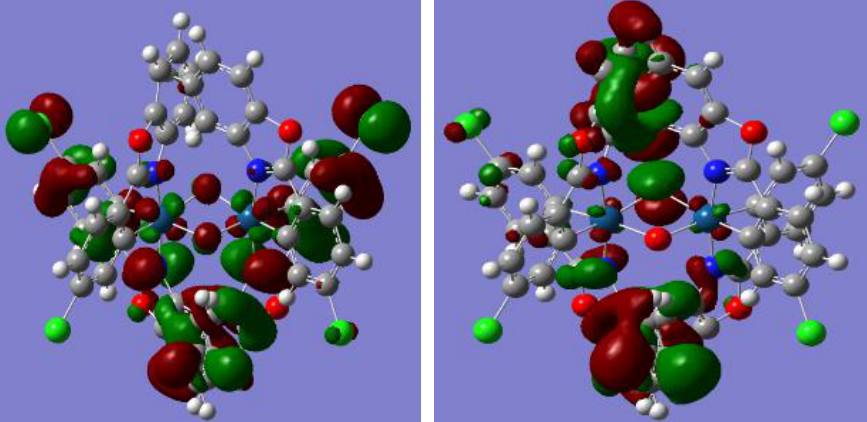
Figure 3. Electron density of the SOMO ( left ) and LUMO ( right ) in [(4cpbo) 2 Ir] 2 ( µ -Cl).